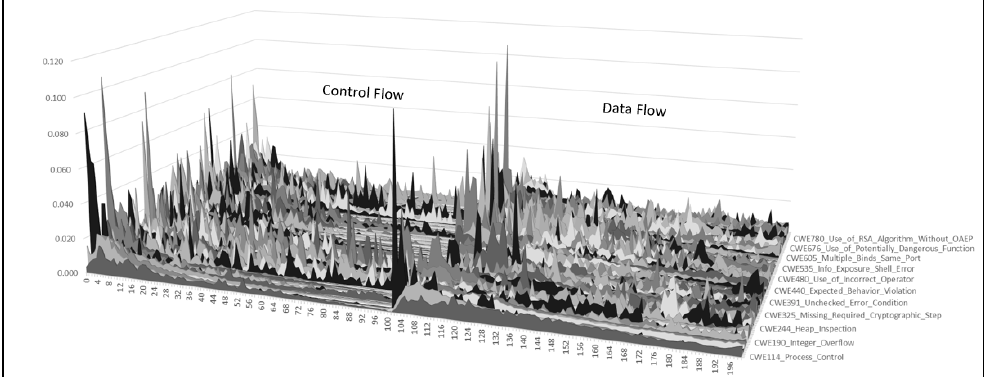
Figure 4. Feature importance for the Intermediate Representation.